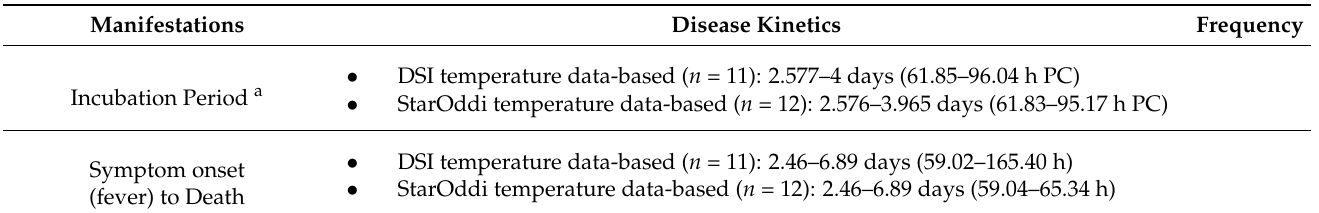
Table 4. Summary of observed kinetics of infection and of key disease characteristics in SUDV- challenged